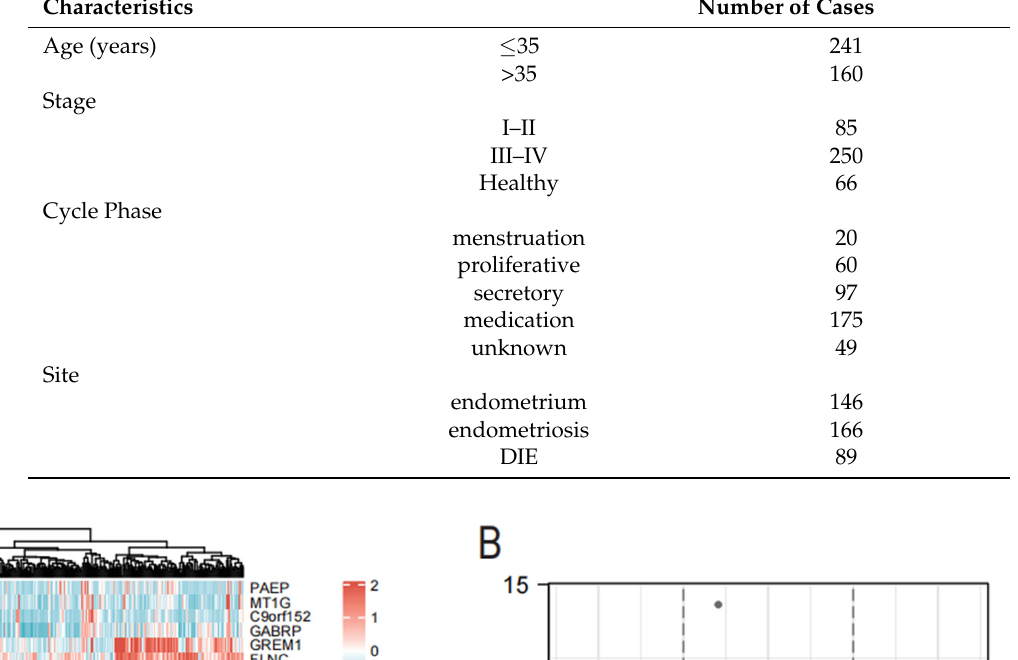
Table 1. Clinical characteristics of the GSE141549 dataset.